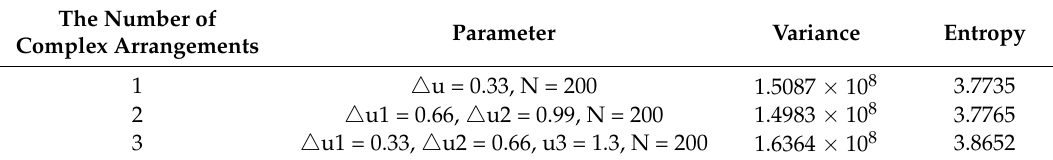
Table 2. Imaging process and reconstruction algorithm.